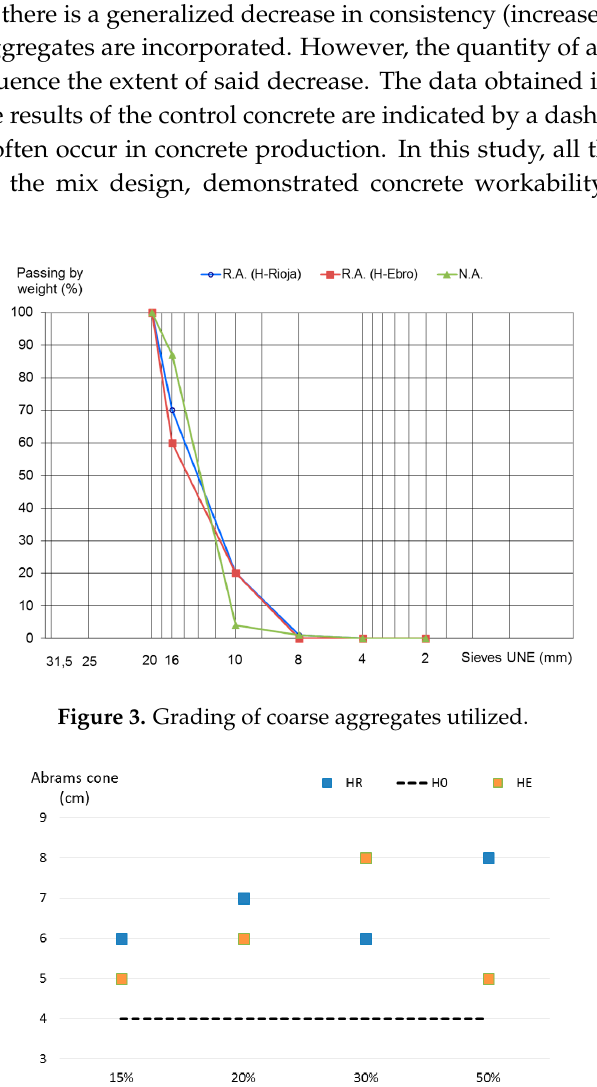
Table 5. Results of the tests conducted on hardened concrete.